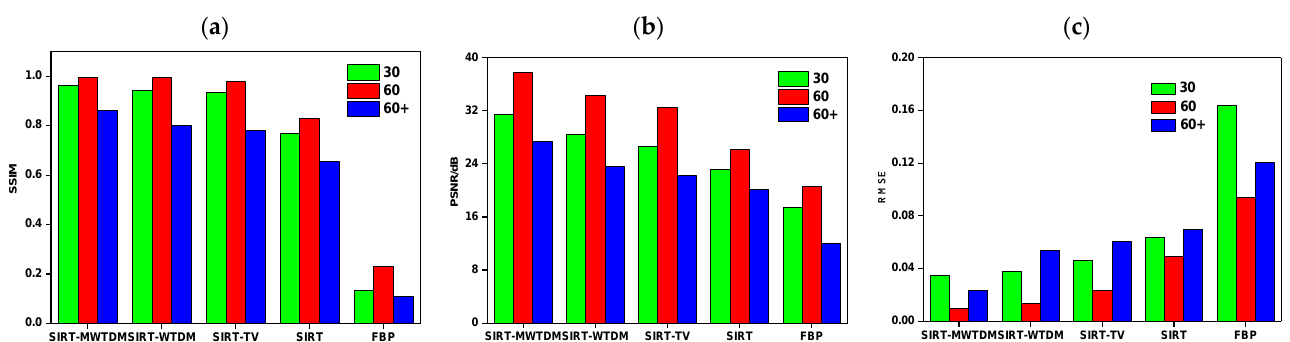
Figure 7. The histograms of evaluation index for reconstructed images of the circular phantom with different numbers of projections. ( a ) SSIM; ( b ) PSNR; ( c ) RMSE. Here, 60+ indicates that Poisson noise is added to 60 projections.